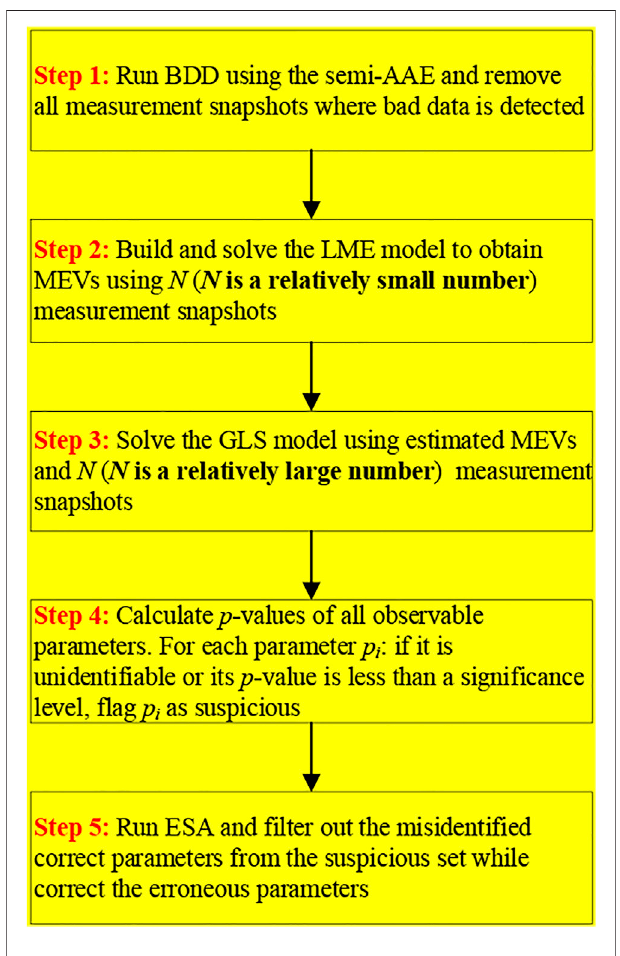
FIGURE 1 | Flow chart of the proposed LME-GLS